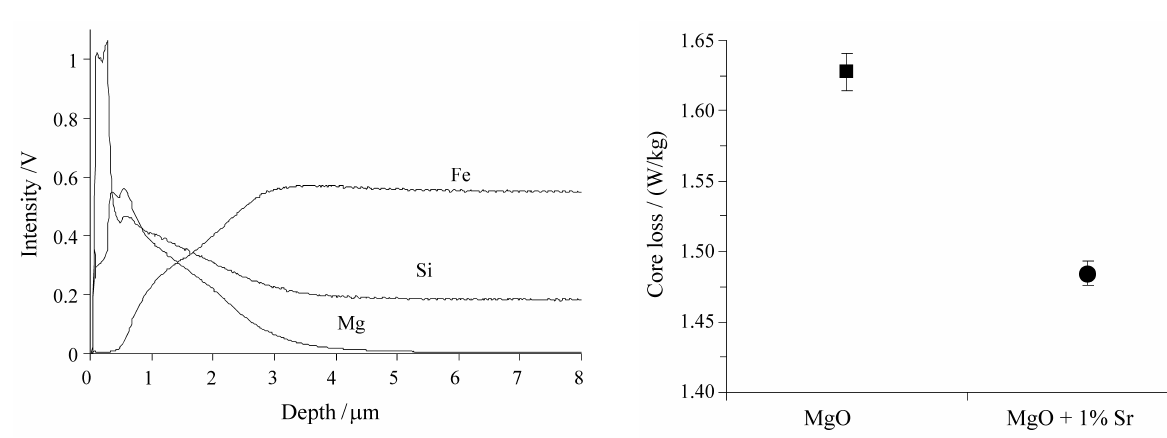
Figure 7. Magnetic core loss for steel sheets coated with MgO and MgO + 1% Sr